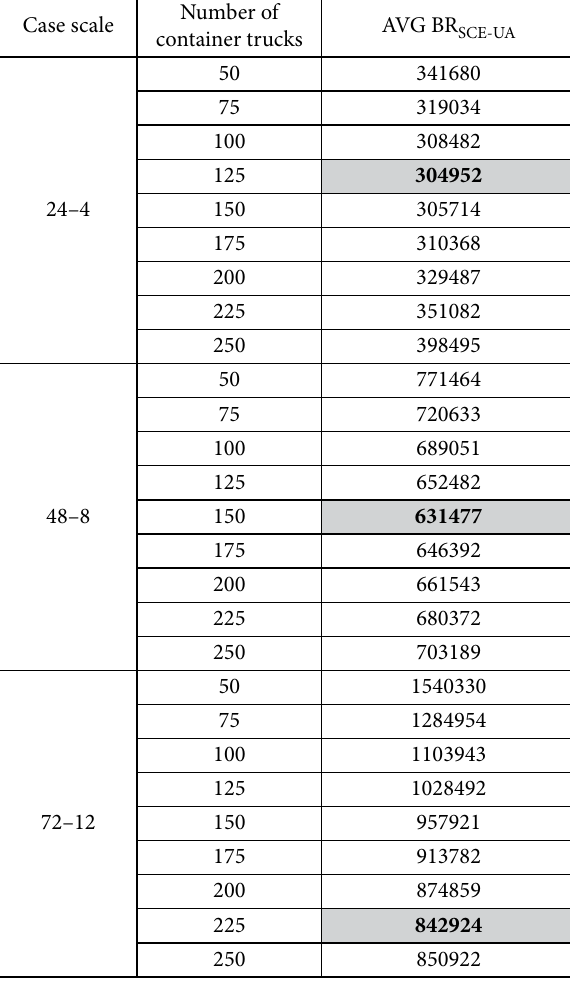
Table 7. Results of cases with different number